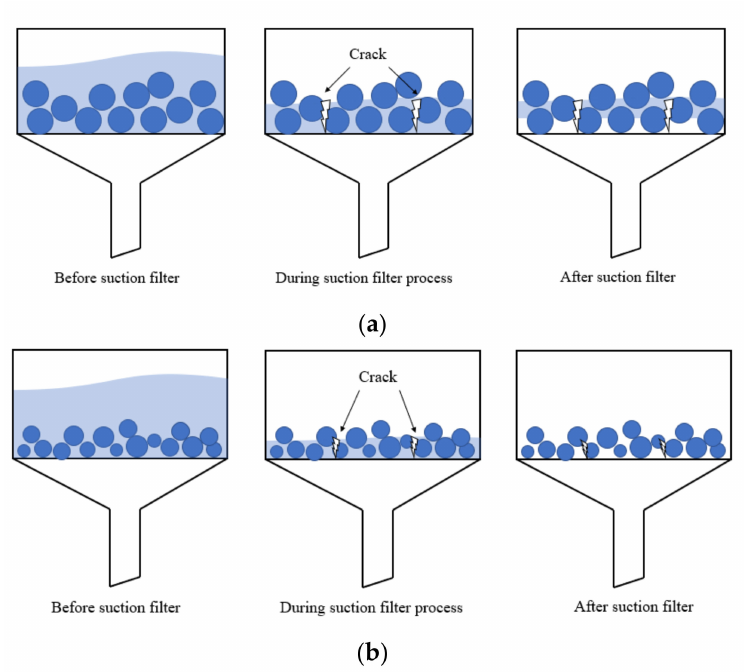
Figure 5. Inter-particle liquid removing process for the suction filtration method: ( a ) SAP A73 with larger absorptivity and ( b ) SAP N with lower